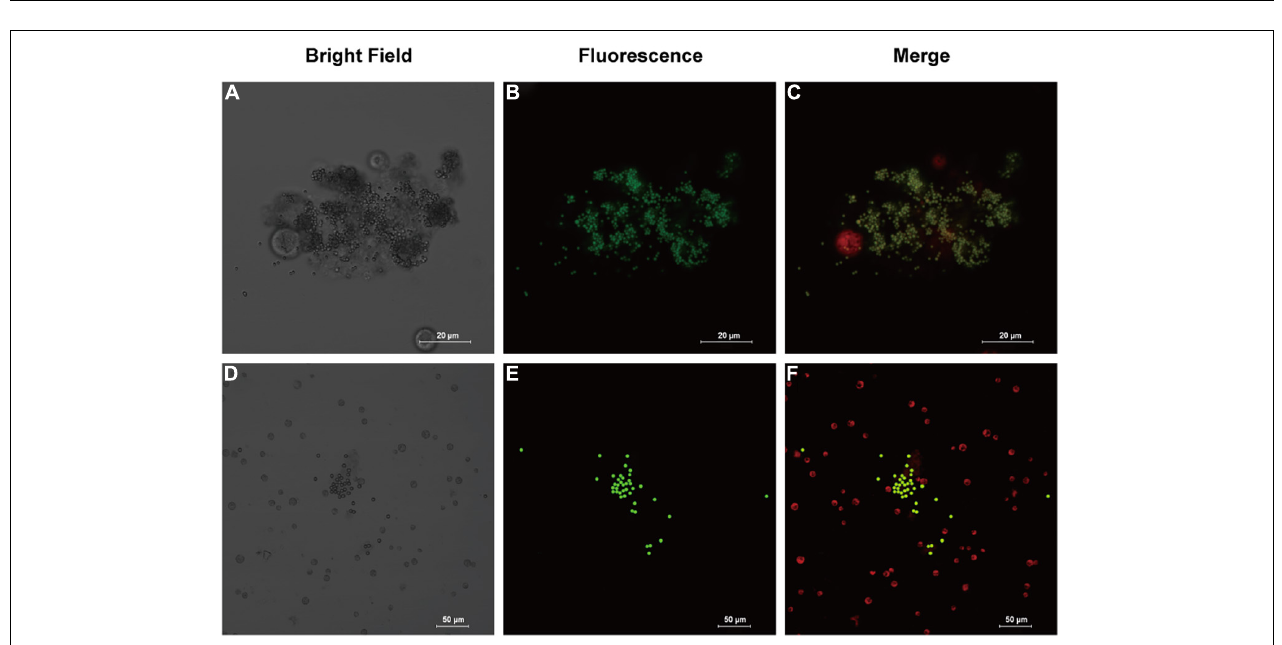
FIGURE 1 | The average growth inhibition ratio of microalgae exposed 96 h to sulfadiazine (SDZ) and polystyrene-microplastics (PS-MPs) in the different groups. (A) Single treatment of SDZ and MPs and (B) 50 mg l − 1 of different particle size MPs + SDZ in comparison with SDZ only. Values are the mean ± SEM of three replicates. Significant differences ( p < 0.05) are denoted with different letters (A) and an asterisk for MPs + SDZ vs. SDZ only (B) .